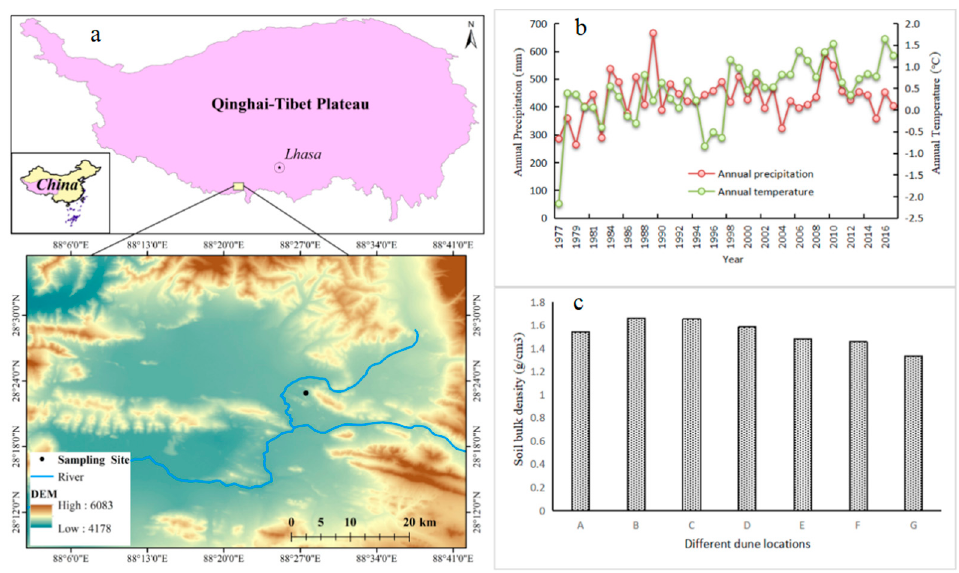
Figure 1. Overview of the study area. ( a ) location and distribution of soil sampling points, ( b ) annual mean temperature and annual precipitation, ( c ) soil bulk density in the study area.